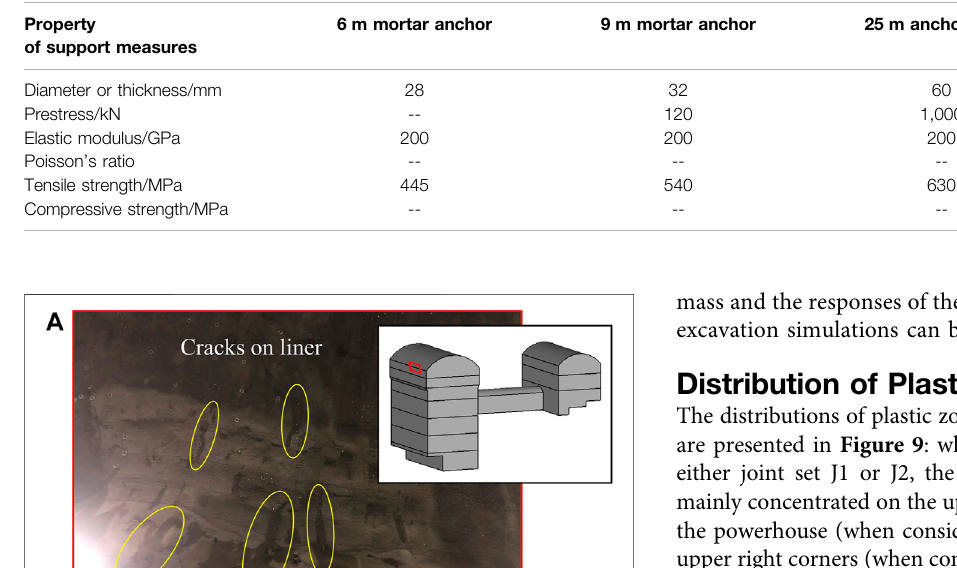
TABLE 3 | Parameters of the support structures.